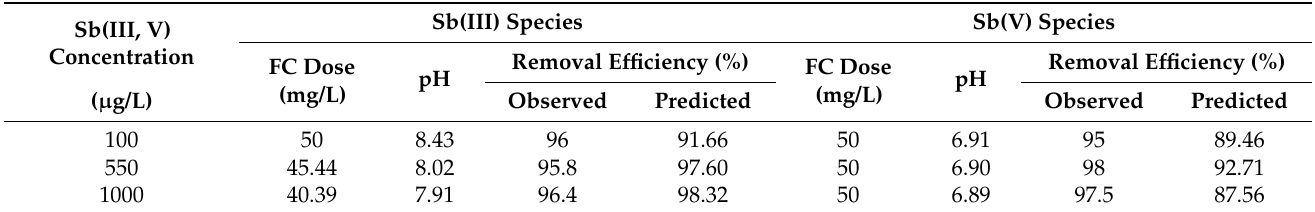
Table 7. Comparison of experimental and predicted Sb(III, V) removal efficiencies under optimum experimental design parameters obtained using Box–Behnken method.